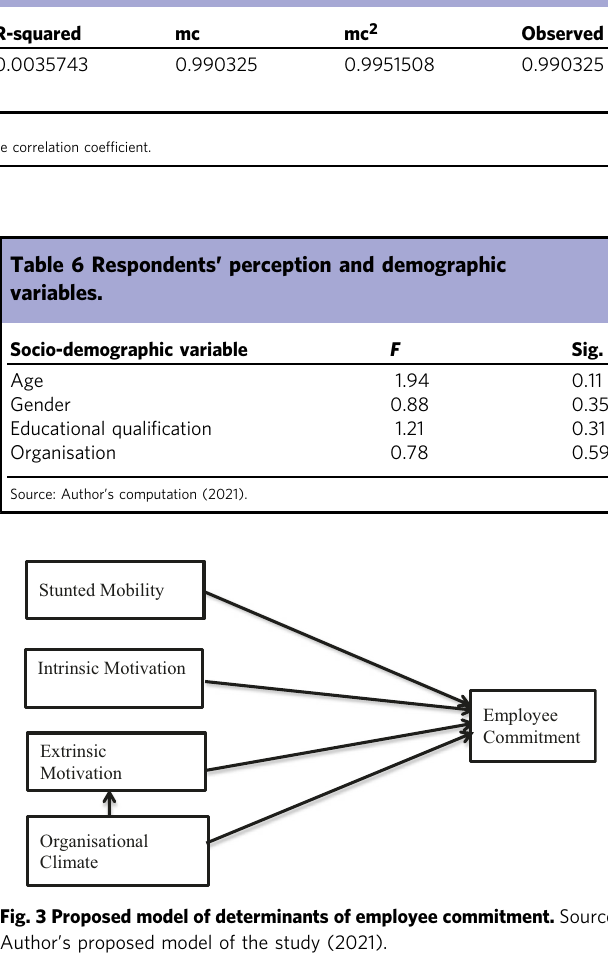
Table 4 Equation-level goodness of fi t.